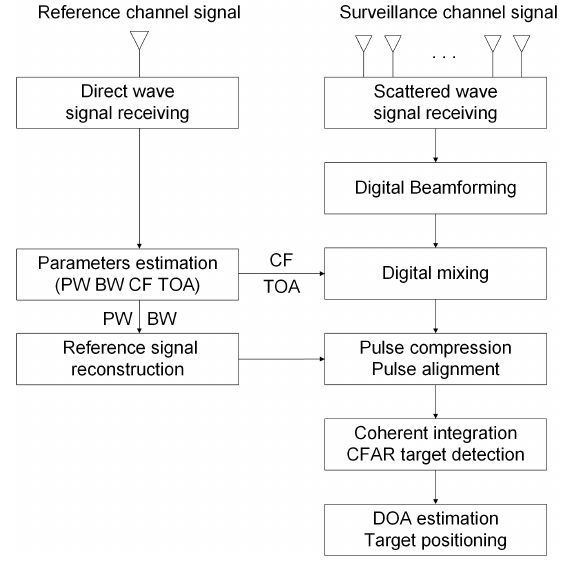
Figure 4. Flow chart of the signal processing method.